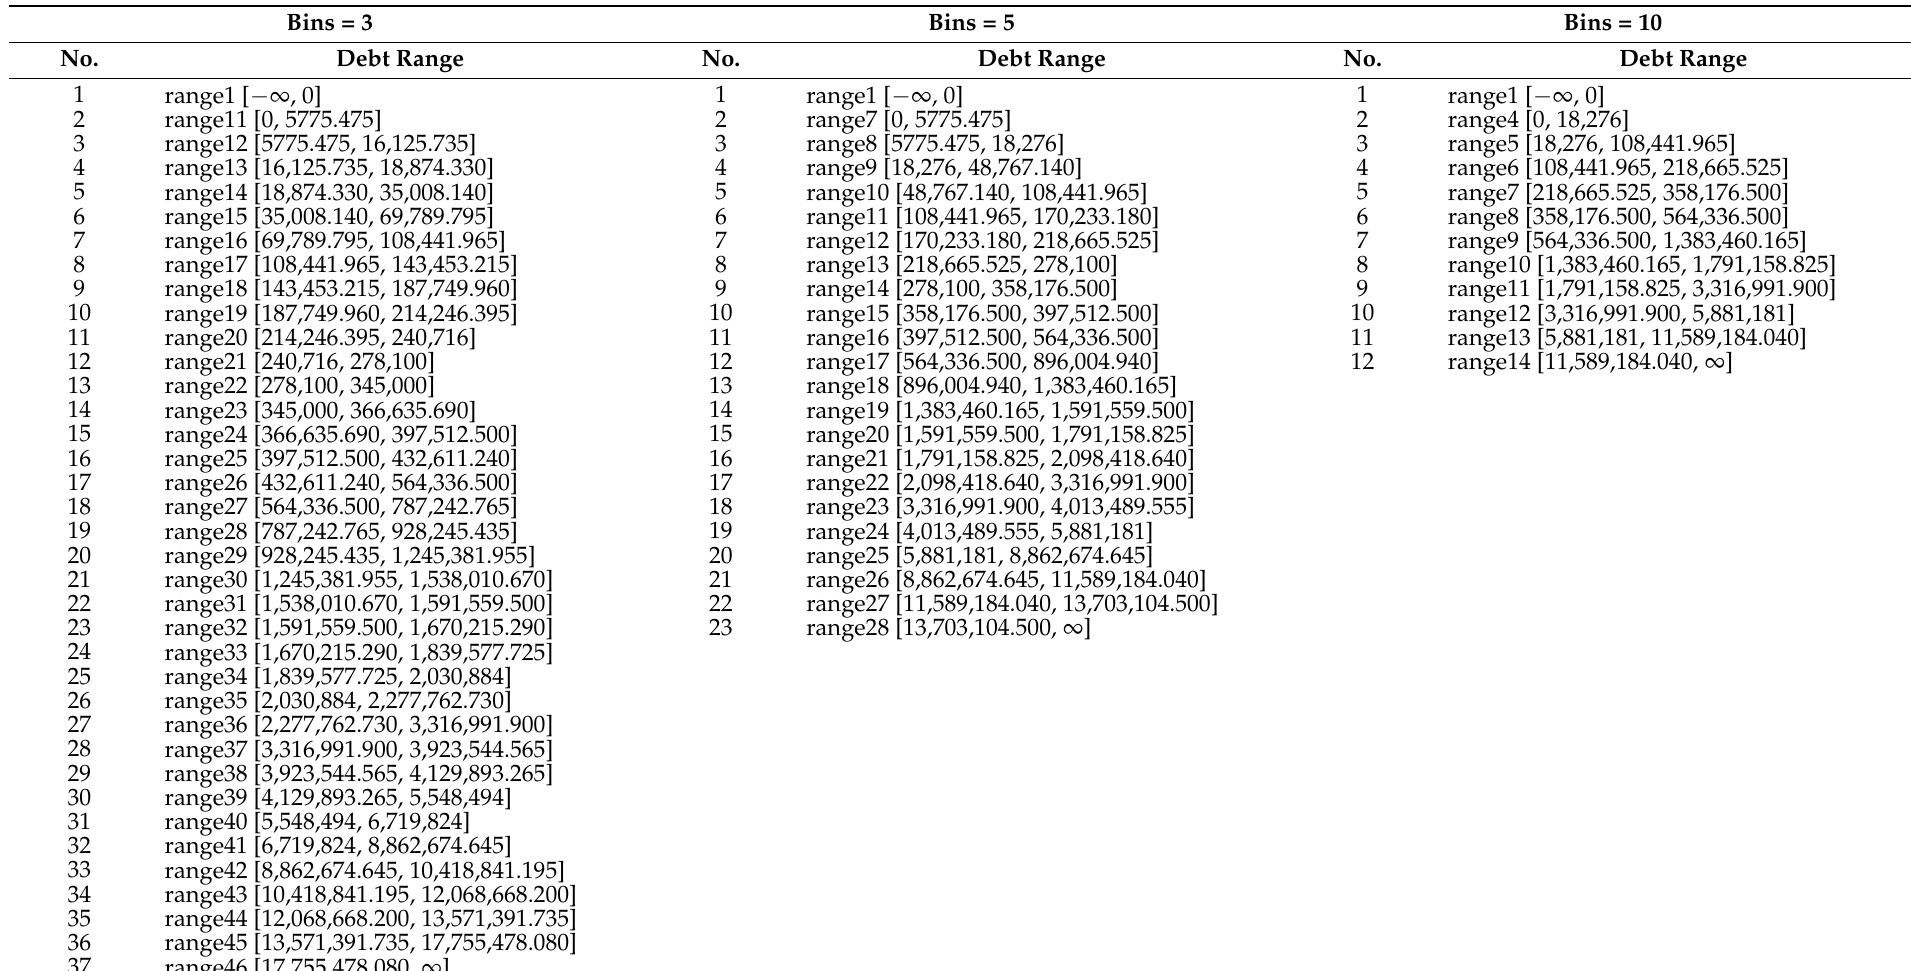
Table 3. Example debt ranges using binning with equal width (number of bins = 3, 5, and